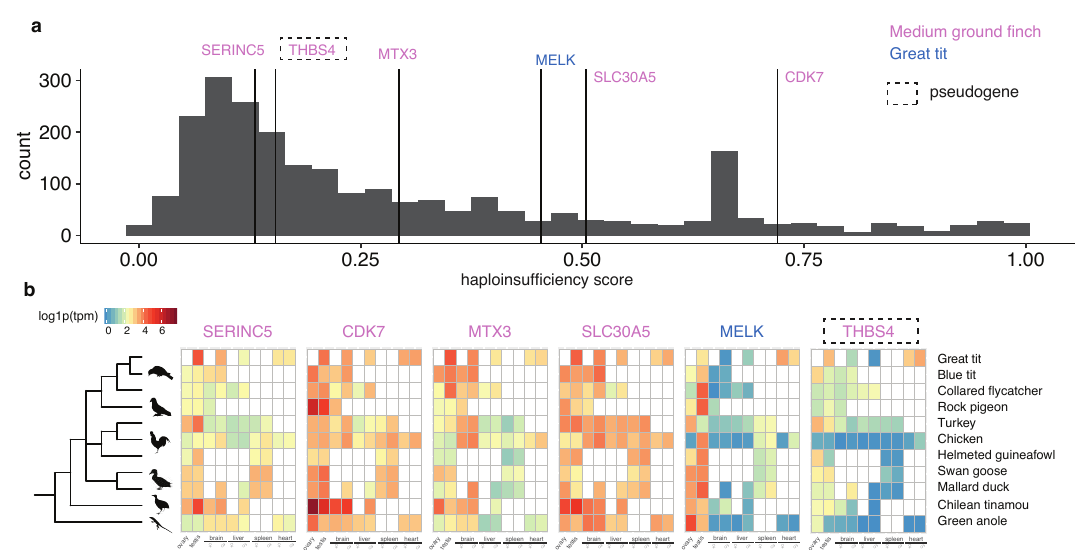
Figure 4. The predicted dosage-sensitivity and expression profile of the transposed genes. ( a ) The distribution of predicted haploinsu ffi ciency scores of human orthologs of all Z-linked genes, marked with ZTR genes. MELK , SLC30A5 and CDK7 have relatively higher dosage-sensitivity (measured by haploinsu ffi ciency scores) than the rest Z-linked genes. ( b ) The expression of the ZTR genes across tissues of both male and female in birds and a reptile. The expression levels were log1p (log 1 + TPM) transformed. The pseudogene was denoted by the dashed